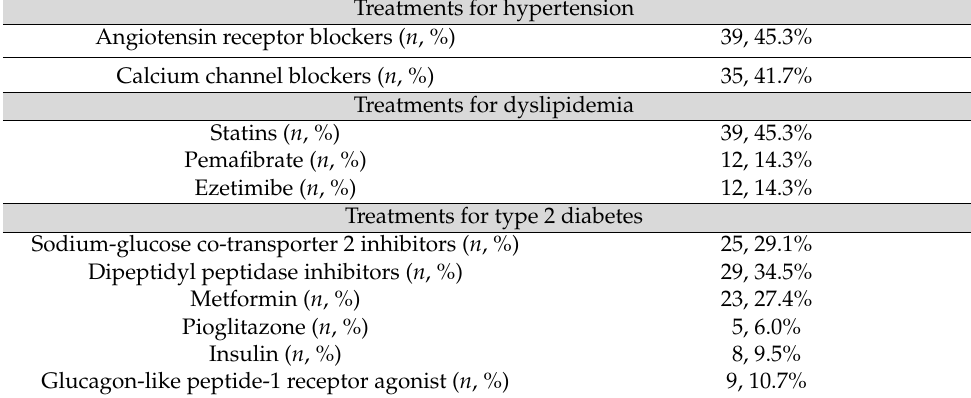
Table 2. Treatments for hypertension, dyslipidemia and type 2 diabetes.